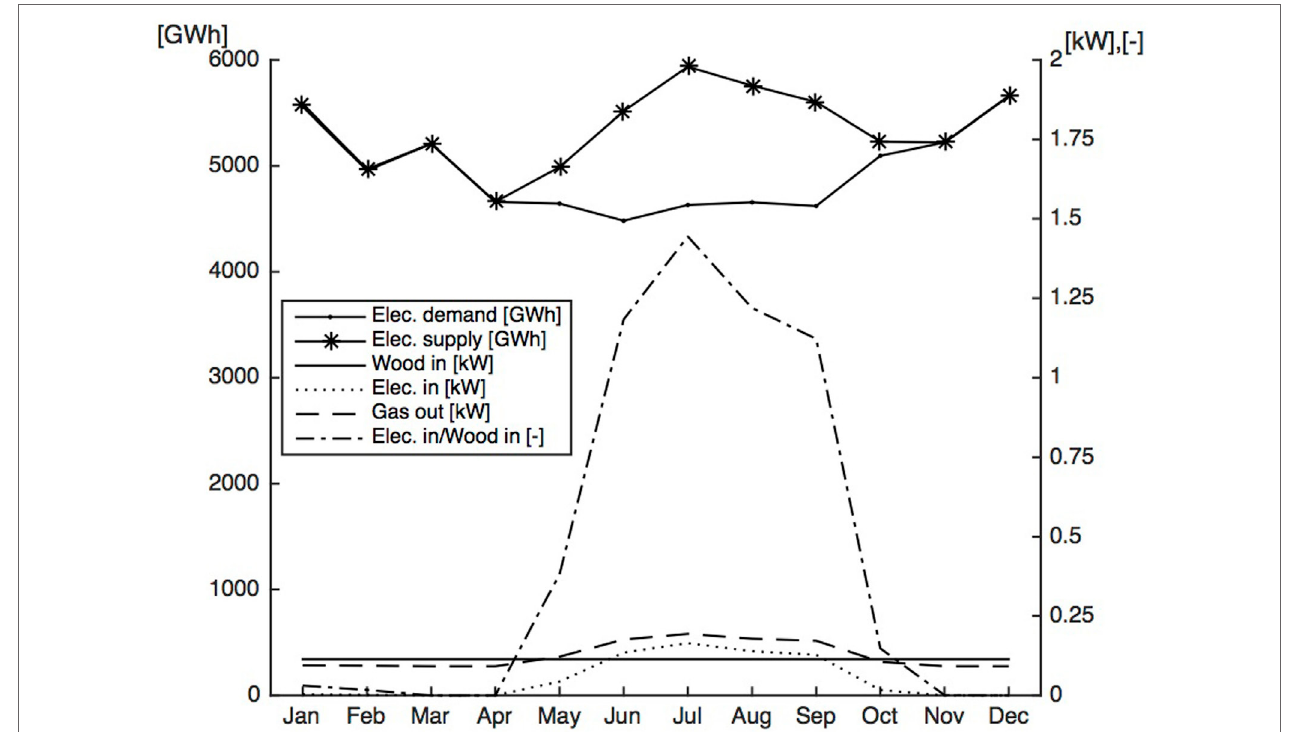
FigUre 9 | Behavior of the bio-SNG and electrolysis system considering electricity supply and demand profiles in the NEP scenario in